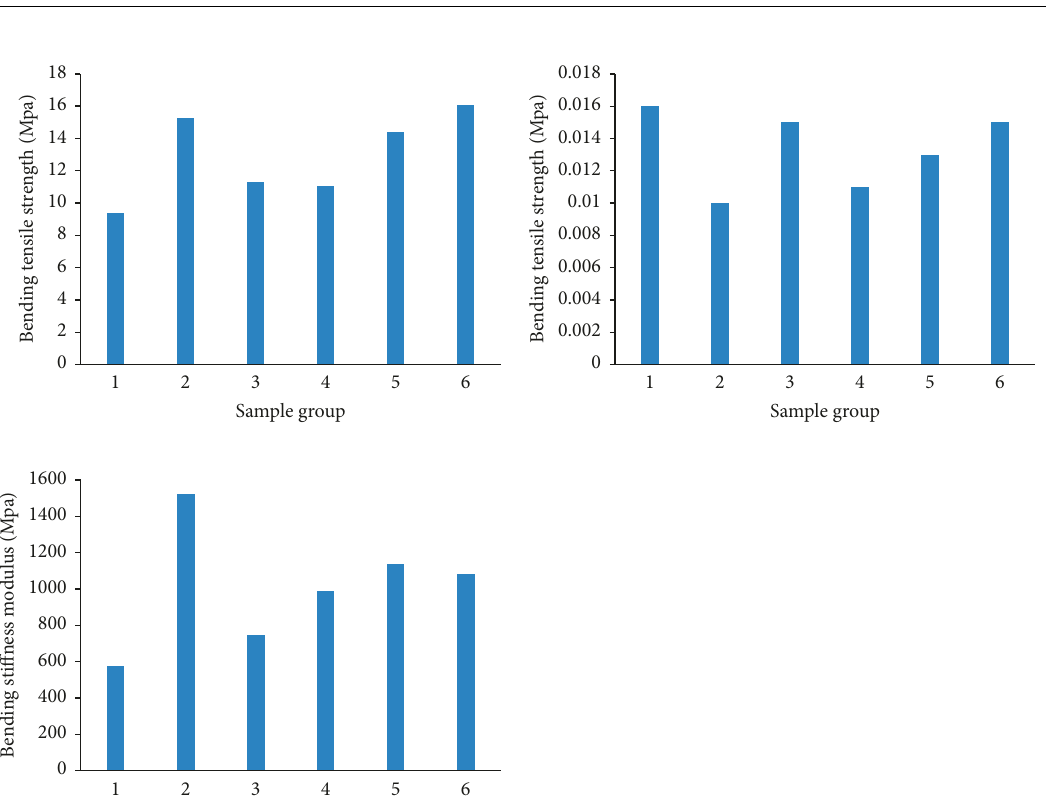
Figure 11: Histogram of trabecular bending test